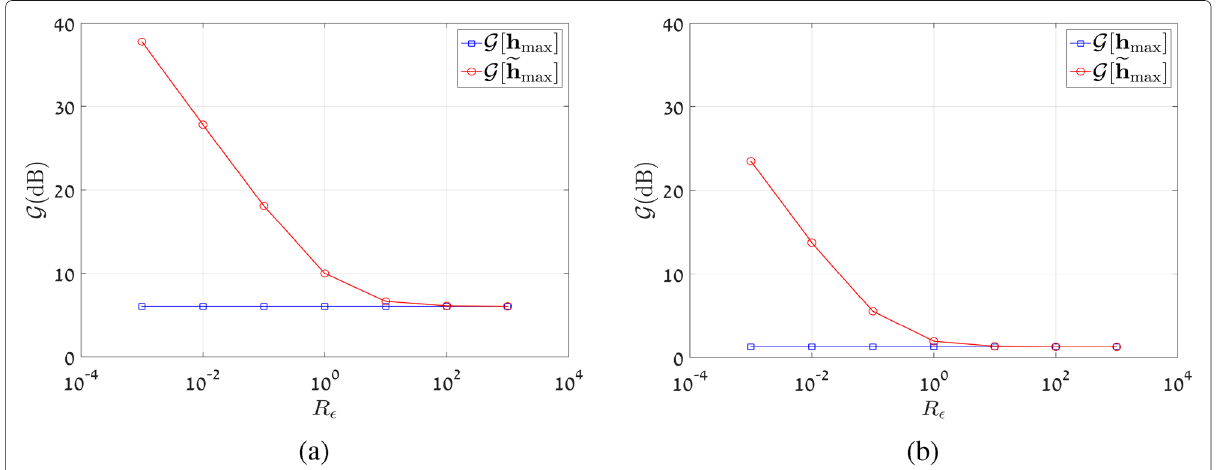
Fig. 1 Theoretical subband SNR gain with the linear and quadratic maximum SNR filters as a function of the ENR for a odd k and b even k